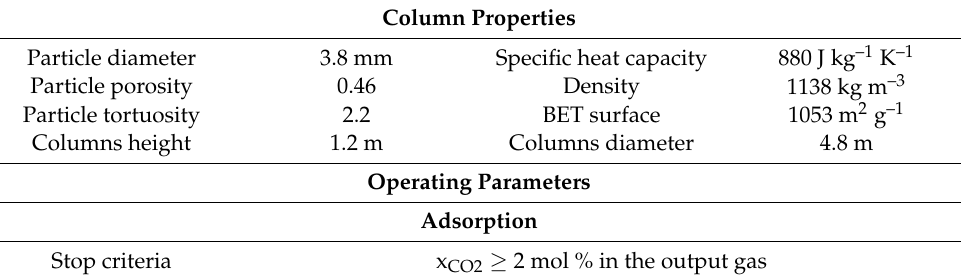
Table 3. Column properties and operating parameters for the TSA